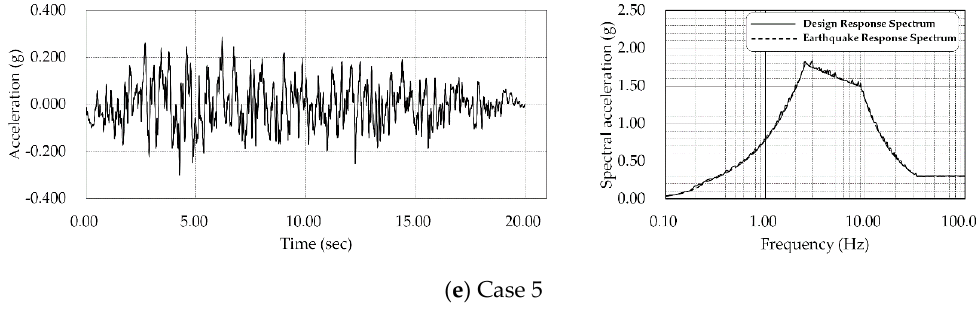
Figure 6. Modified earthquake and comparison of design and earthquake response spectrum.